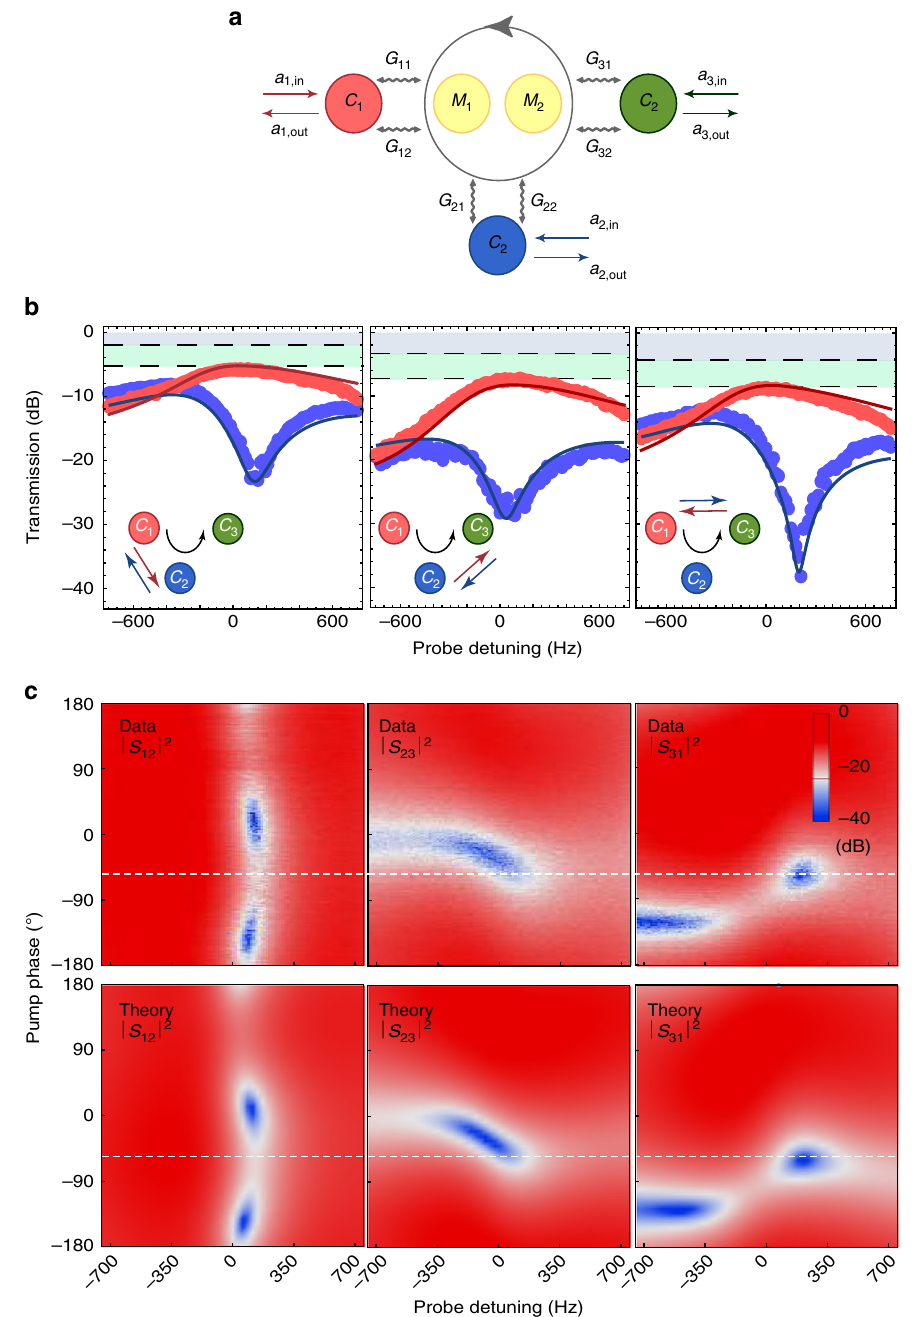
Fig. 3 Electromechanical circulator. a Mode coupling diagram describing the coupling between three microwave cavities ( C 1 , C 2 and C 3 ) and two mechanical modes ( M 1 and M 2 ) with electromechanical coupling rates G ij (where i = 1, 2, 3 and j = 1, 2), creating a circulatory frequency conversion between the three cavity modes, as indicated by the grey arrow. b Measured power transmission in forward | S 21 | 2 , | S 32 | 2 and | S 13 | 2 (red dots) and backward directions | S 12 | 2 , | S 23 | 2 and | S 31 | 2 (blue dots) as a function of probe detuning for a pump phase ϕ = − 54 º . The solid lines show the prediction of the coupled- mode theory model discussed in the text. The inset shows the signal propagation between the three resonator modes and the black arrow indicates the circulator direction. Grey shaded areas denote cavity loss and green shaded areas insertion loss. c Measured S parameters and theoretical model as a function of detuning and pump phase. Dashed lines indicate the line plot positions shown in b